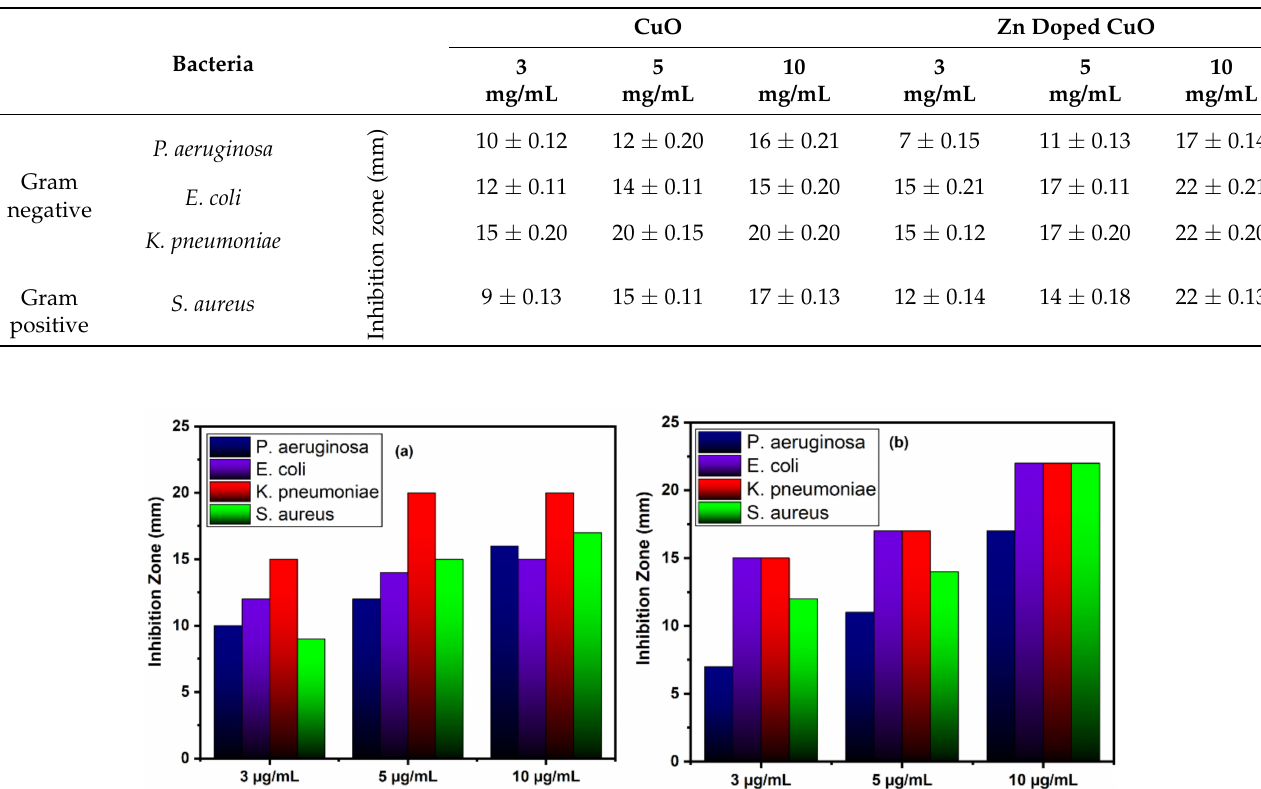
Table 1. The table summarizes the detail of bacteria and other experimental parameters.